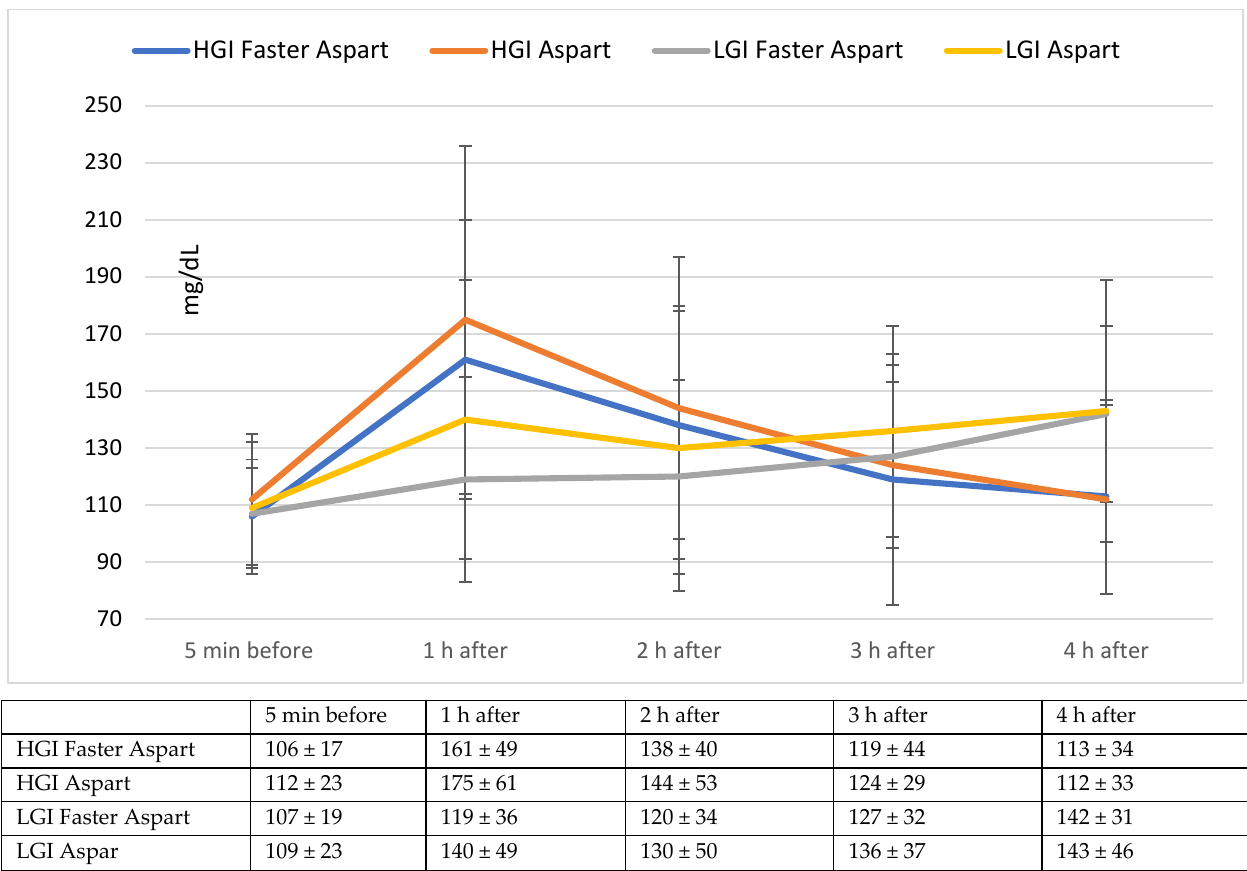
Figure 1. Blood glucose measurements (mean ± SD) 5 min before the meal and 1-2-3-4 h after the meal.